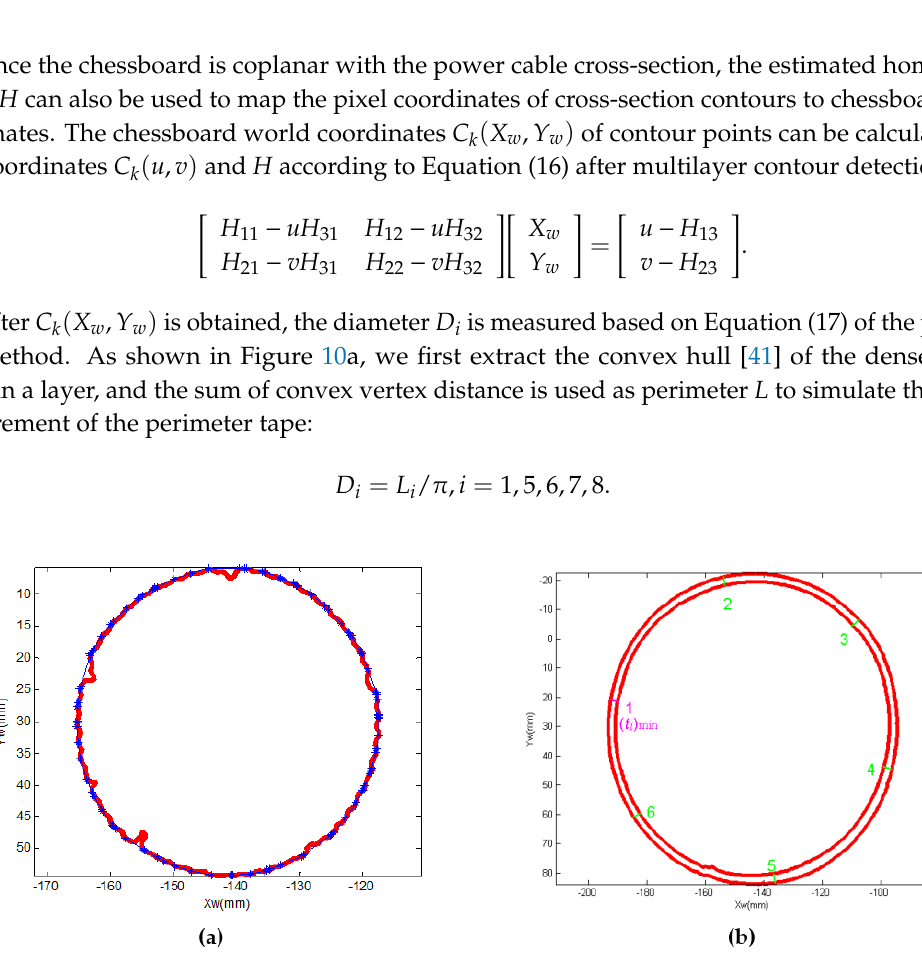
Figure 10. Cross-section measurement. ( a ) Perimeter measurement, in which red dots are contour C k and blue asterisks are vertexes of convex hull; ( b ) Thickness measurement, in which magenta line is minimum thickness and green lines are the other five thickness measurements